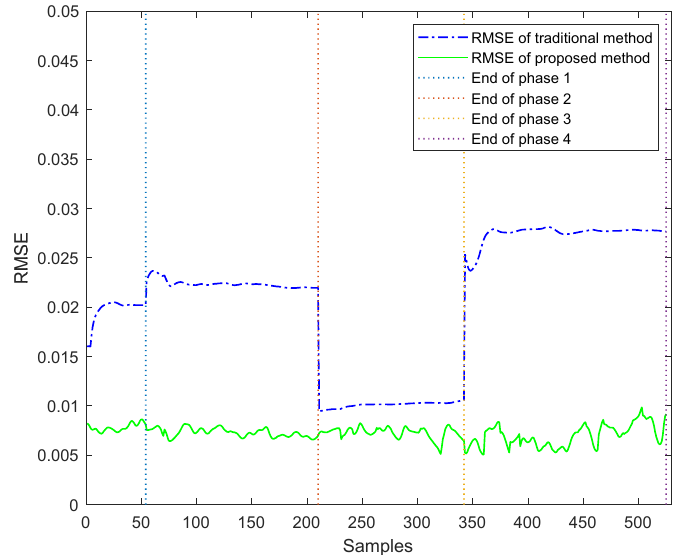
Figure 3. RMSE values of online quality predictions.